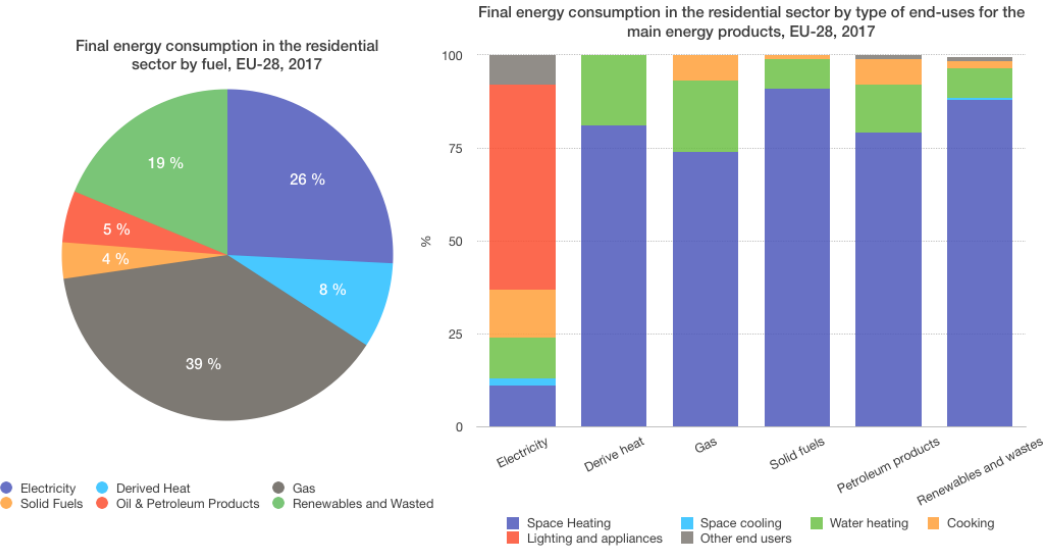
Figure 1. Final energy consumption in the European residential sector from Eurostat survey